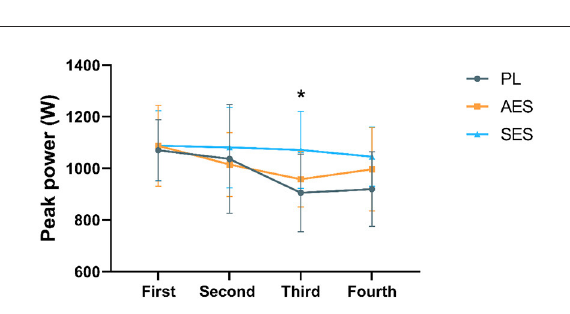
FIGURE3 Peak power results of each WAT. * Indicates a significant difference between serial enteric-coated group and placebo group ( p < 0.05).